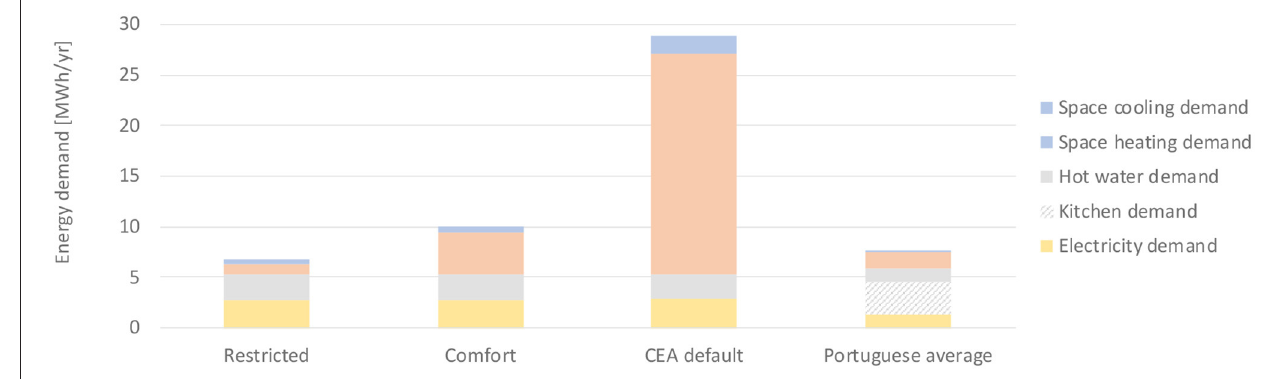
FIGURE 5 | E1 energy demand per